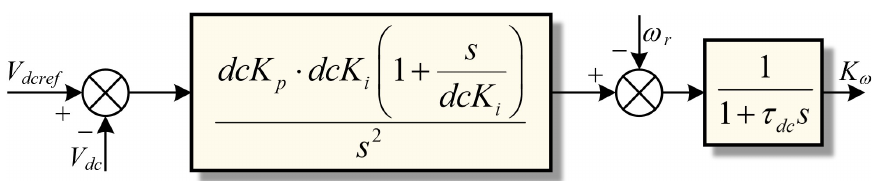
Figure 5. The energy feedback control